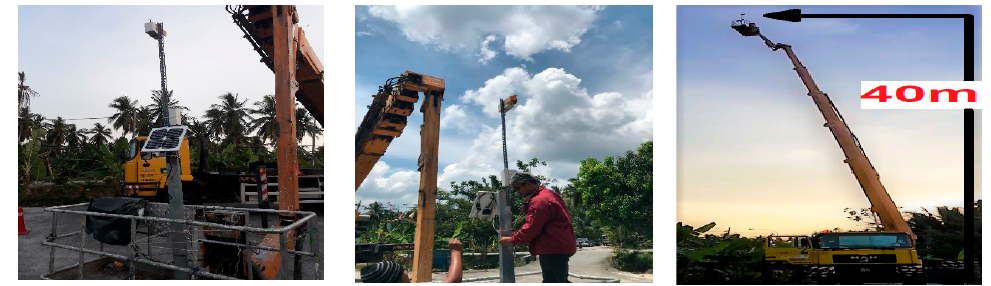
Figure 6. Completed transmission node enclosed in a weatherproof box and fixed on top of a Skylift crane at a height of 40 m.